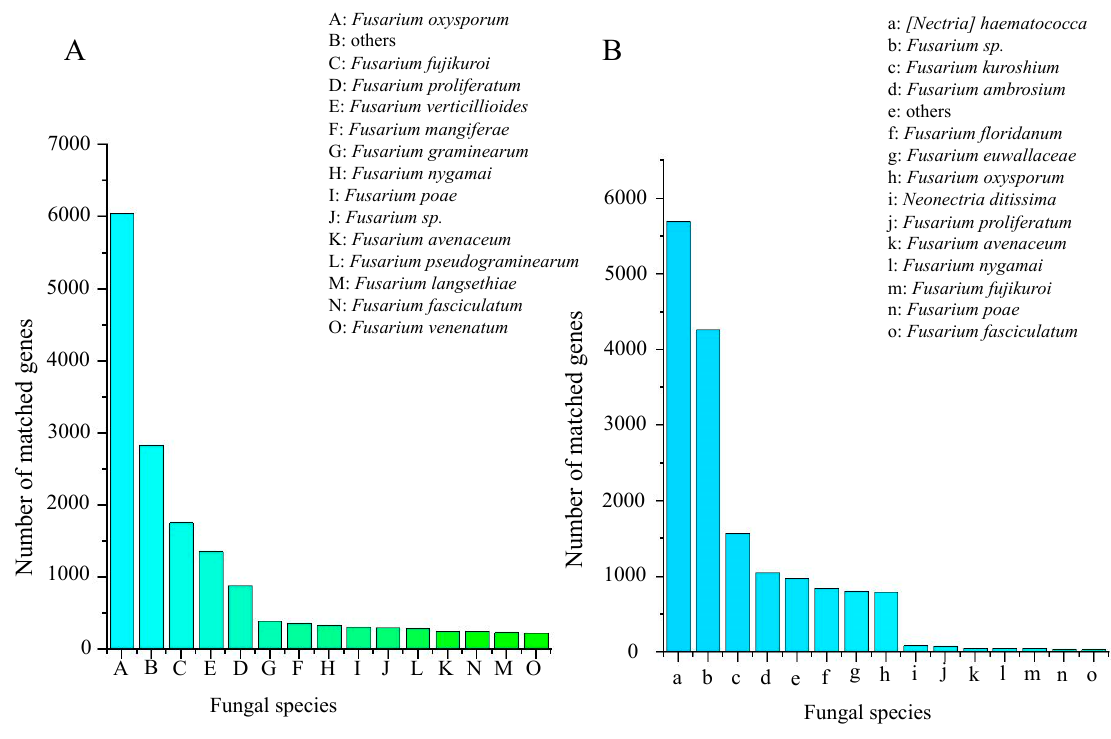
Figure 2. Results of the NR annotation results for strains QK8 ( A ) and SX13 ( B ) (15 strains).